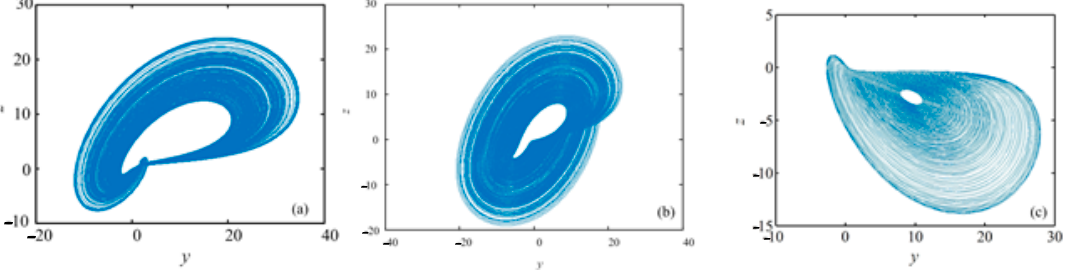
Figure 12. Phase diagram of chaotic attractor; ( a ) a = 3, c = 7, d = 31; ( b ) a = 3, c = 7, d = 11; ( c ) a = 3, c = 2, d = 31.